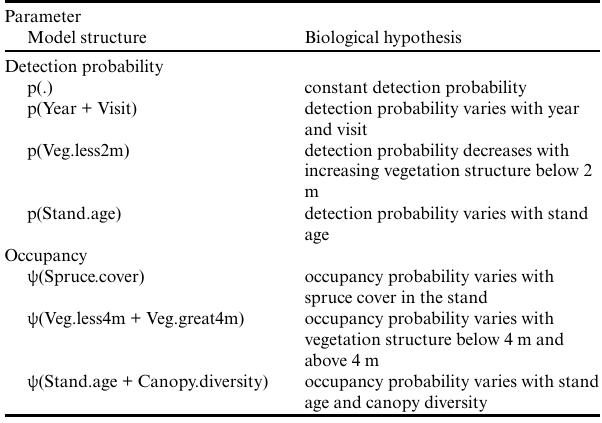
Table 5 . Biological hypotheses tested on detection probability (p) and occupancy ( ψ ) of forest birds from the detection data obtained from four 10-min recordings in 2013 and 2014 at 109 stations in Hearst Forest Sustainable Forest License, Ontario, Canada.